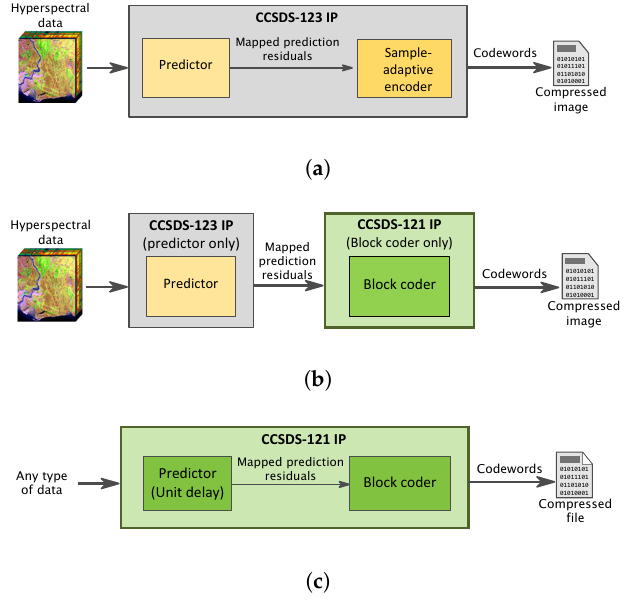
Figure 4. General overview of SHyLoC 2.0. ( a ) CCSDS-123 IP standalone; ( b ) CCSDS-123 predictor with CCSDS-121 entropy coder; ( c ) CCSDS-121 IP